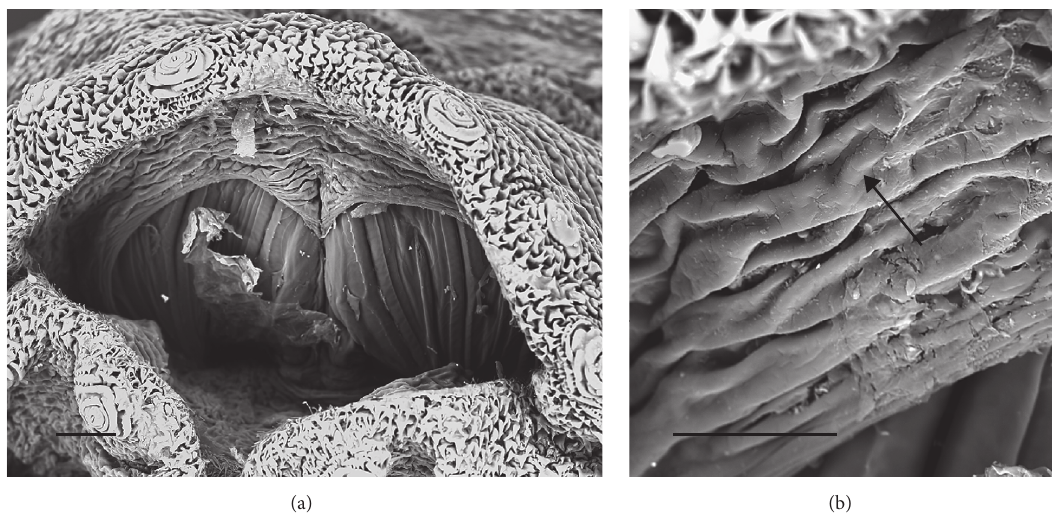
Figure 4: Sarcophaga sp. third instar larva: SEM images. (a) Overview of the posterior spiracle cavity. (b) Detail showing highly wrinkled edge of the posterior cavity (arrow). Scale bar: 100 𝜇 m (a); 30 𝜇 m